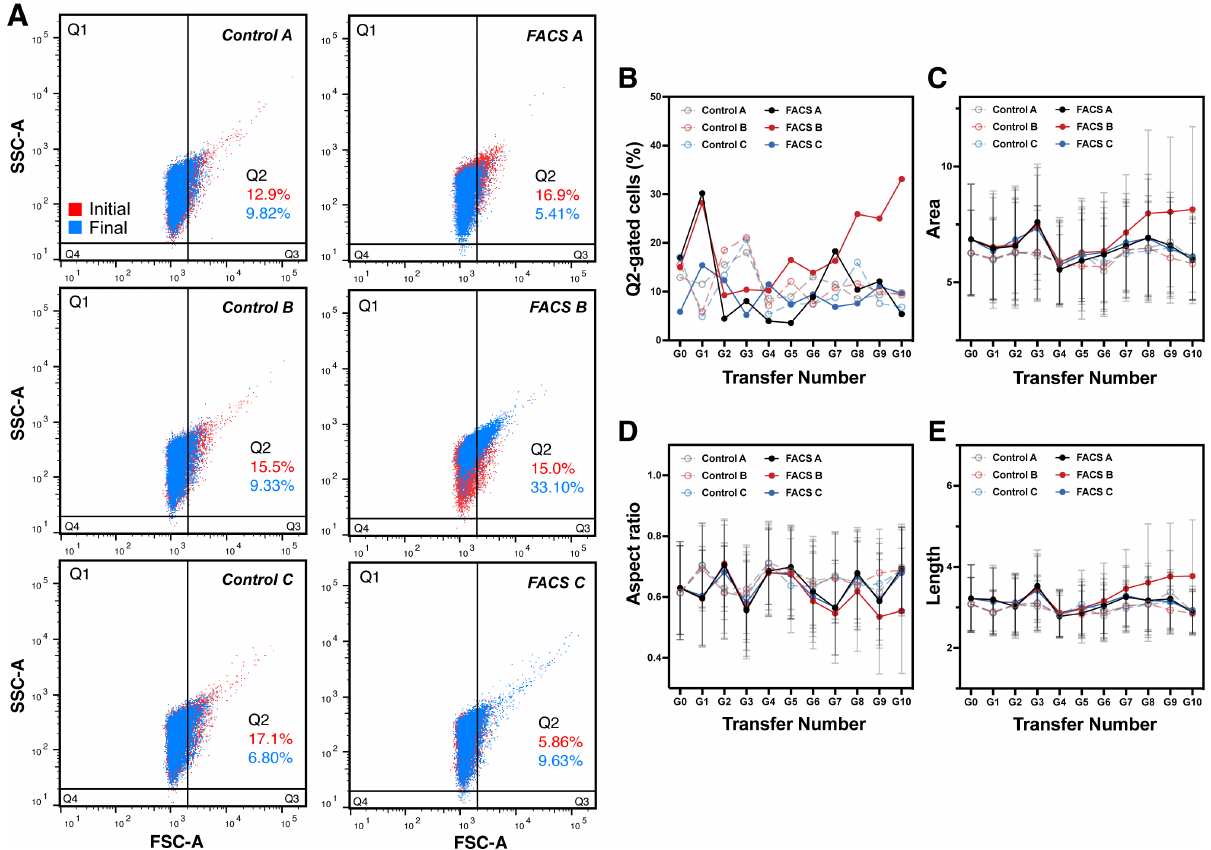
Figure 2. Dynamics of cell morphology of passaged cells with or without cell sorting pressure. ( A ) Cell population analysis via FACS represented initial (G0, red) and final (10th cycles, G10, in blue) cells. The percentages of six gated cell populations were indicated. Detailed dynamics of all 10 cycles (G1–G10) were shown in ( B ) (Population of Q2-gated cells), ( C ) (Cell area), ( D ) (Aspect ratio), and ( E ) (Length). The red line shows the trend of each parameter from the FACS-B group.